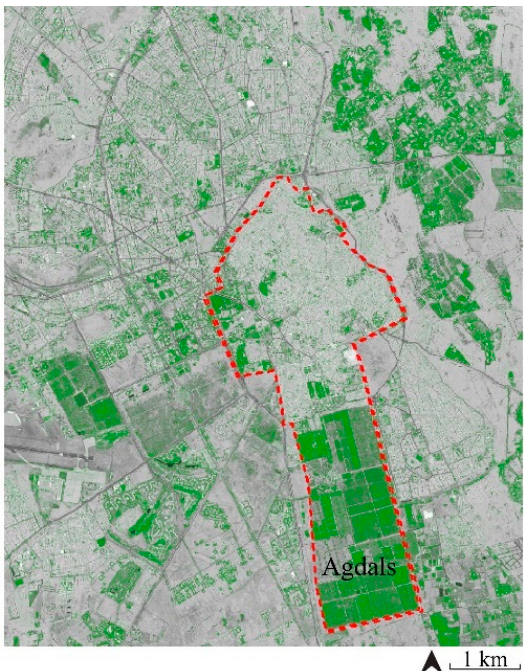
Figure 10. The UNESCO heritage site delimitation of Marrakesh Medina and the green spaces in the green elements in different areas of the Medina and create inclusive public spaces where territory (data source: Authors). the community will participate in setting up the project (see Figures 12 and 13) [41,42].